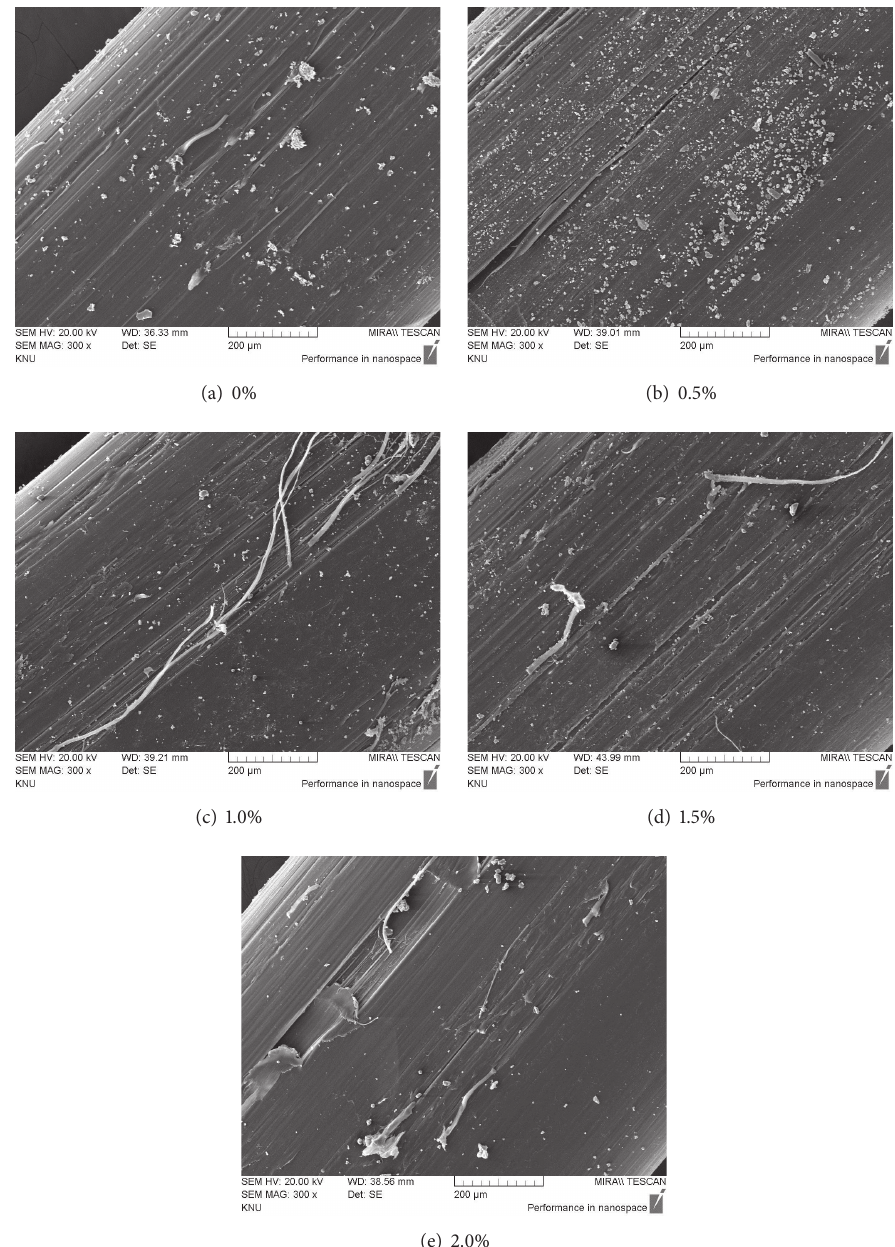
Figure 7: Microstructure of fiber surface in LMHFRCCs ( 𝑤/𝑐 = 0.5